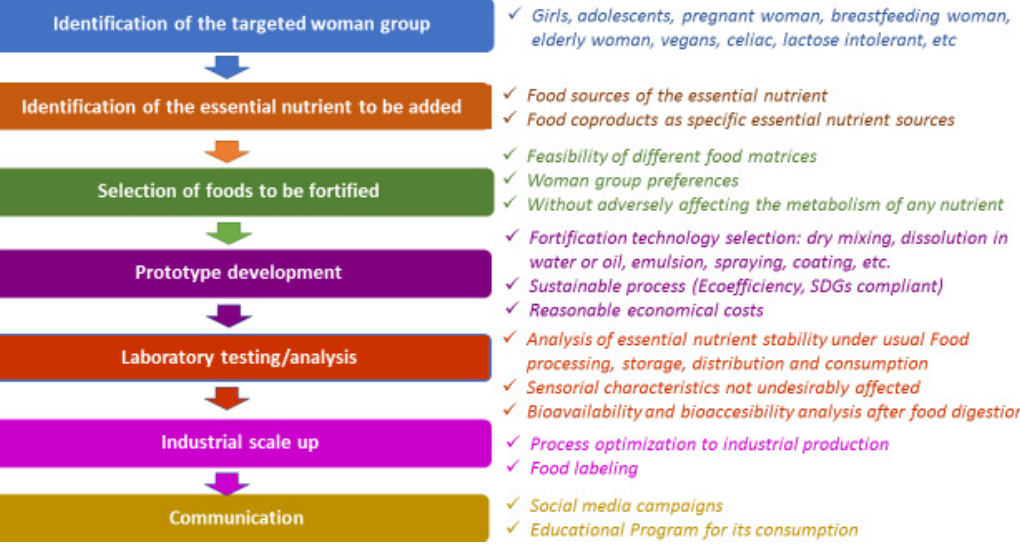
Figure 2. Main steps in the development of fortified foods for women.